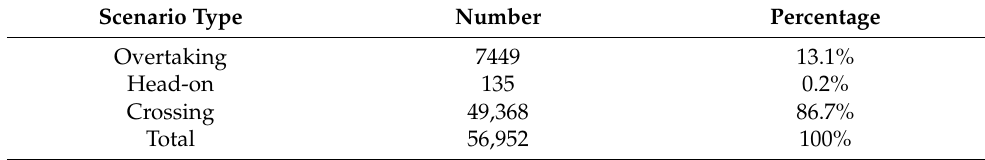
Table 3. Number of testing